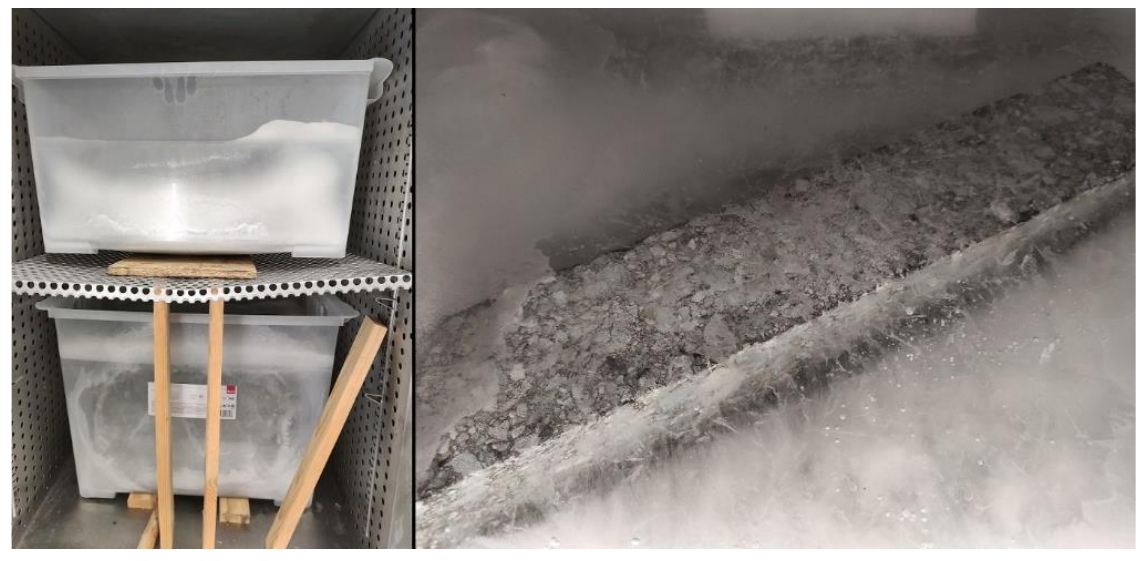
Figure 3. Camber view: water-frost impact [11].